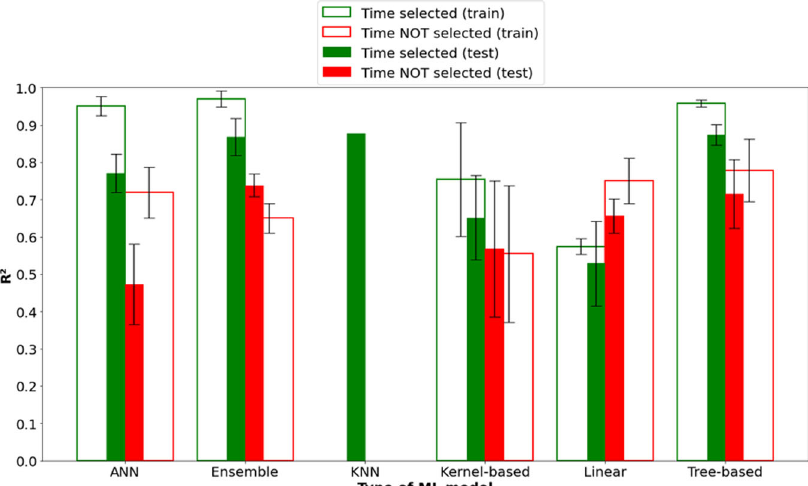
Fig. 4 The mean R² as a function of the ‘ Type of ML model ’ , depending whether the Time was selected as a feature or not. Both training and testing performances were considered for all references using R² as an evaluation metric 1 – 4,6 – 17,19 (ML for corrosion database 43 ). The error bars represent the standard deviation of the